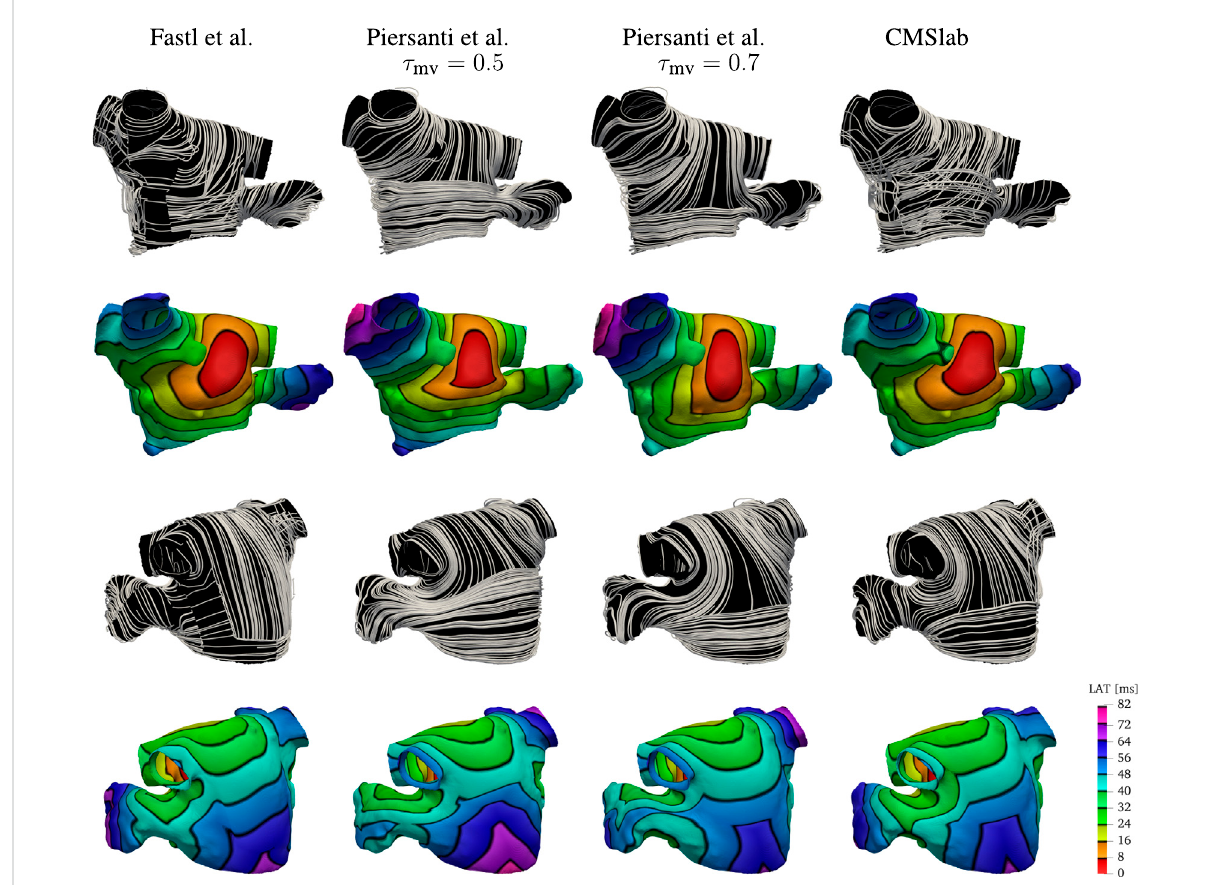
FIGURE 8 Comparison ofthe results obtained using theproposed fi ber construction algorithm and previously proposed byFastl etal. (2018) and Piersanti et al. (2021). Using one of the three geometries provided by Fastl et al. (2018), we have built the fi bers using the method proposed by Piersanti et al. (2021) using two possible threshold values for the parameter τ mv de fi ning the extent of the Bachmann ’ s bundle. The fi ber direction for the Fastl et al. (2018)modelconstructionwereavailablewiththemesh.Thiscomparisonshowsthattheproposedalgorithmforthede fi nitionofthe fi ber fi eld on the left atrium capture the essential features of the complex algorithm proposed by Fastl et al. (2018), while maintaining the simplicity of the Piersanti et al. (2021). Because the simple algorithm proposed by Piersanti et al. (2021) considers only a single layer of fi bers, the activation times on the anterior wall show a higher degree of anisotropy. Note that with this algorithm, the right superior pulmonary vein is one of the last regions to be activated, whereas propagation in the LAA does not follow the expected ostium-to-tip